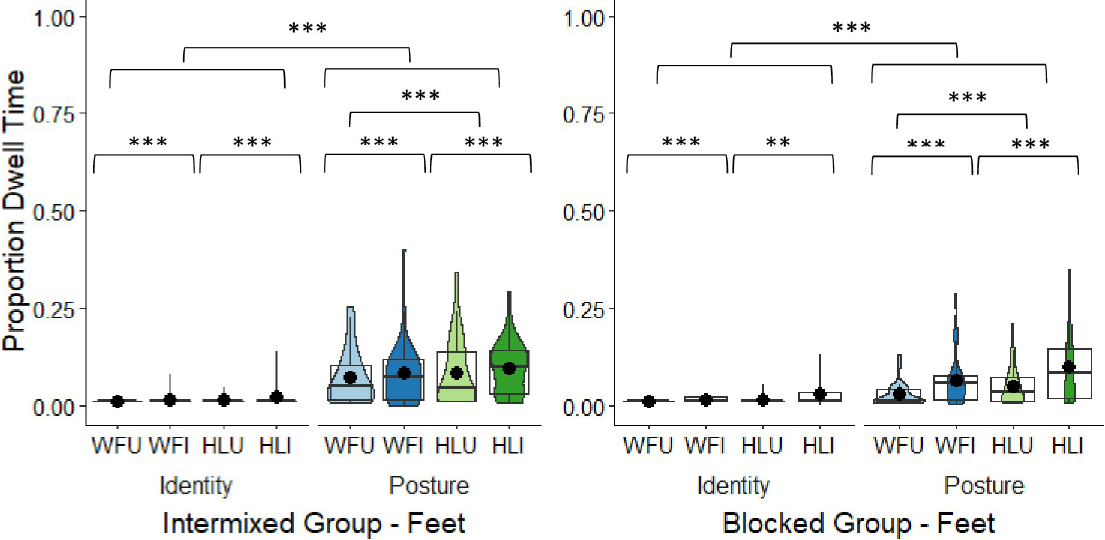
Fig 8. Intermixed and blocked groups’ box and violin plots of dwell time (DT) proportions to the feet in the whole figure upright (WFU), whole figure inverted (WFI), headless upright (HLU), and the headless inverted (HLI) conditions in the identity and posture tasks; dots denote means; ��� = p < .001; �� = p <